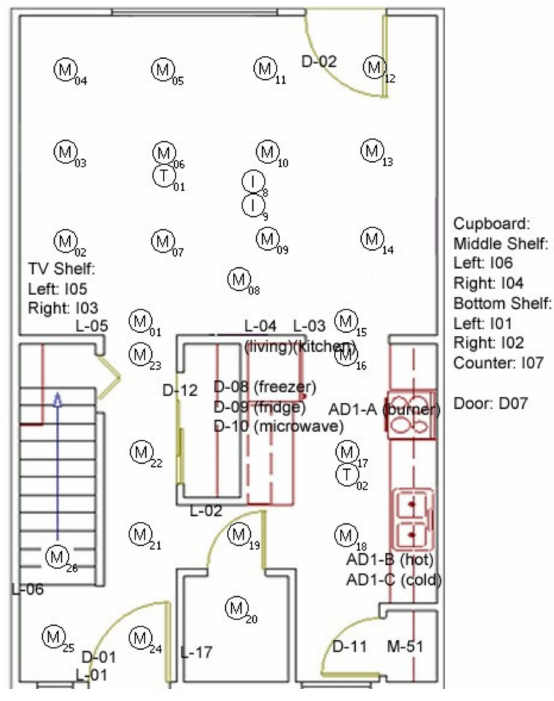
Figure 3. Layout of the IoT sensors in CASAS dataset. Table 1. Activities performed by the